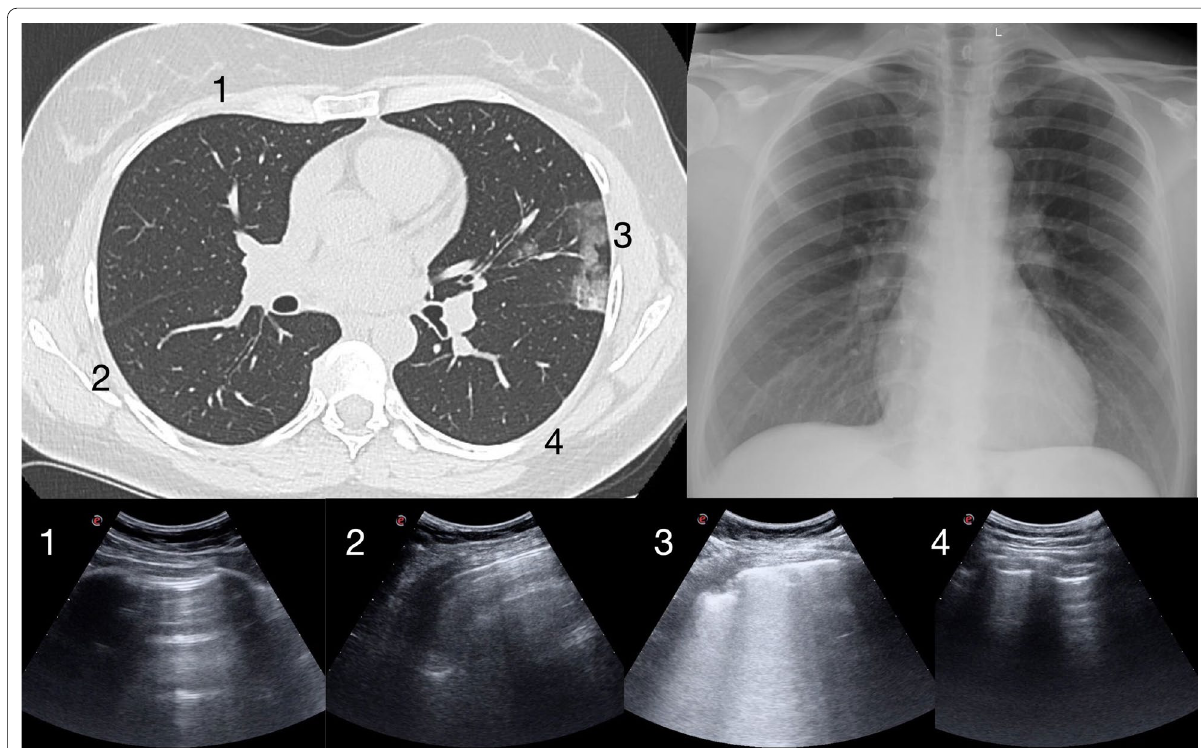
Fig. 4 The case of an otherwise healthy 44-year-old woman complaining of malaise, anosmia, fever and cough for 4 days ( mild phenotype ). LUS and CXR were in disagreement. LUS showed an intermediate probability pattern for COVID-19 pneumonia. One of the LUS scans reported in the bottom shows an isolated area with B-lines, light beam and a peripheral consolidation (3). The other LUS scans show A-lines (1, 2, 4). CXR in the upper right panel was read negative . Corresponding CT scan in the upper left panel shows a limited peripheral area with GGO and a consolidation and was considered indeterminate appearance . The points numbered in the CT scan correspond to the 4 LUS scans. Viral RT-PCR was positive. LUS Lung Ultrasound, CXR Chest Radiography, COVID-19 Corona Virus Disease 2019, GGO Ground Glass Opacity, CT Computed Tomography, RT-PCR